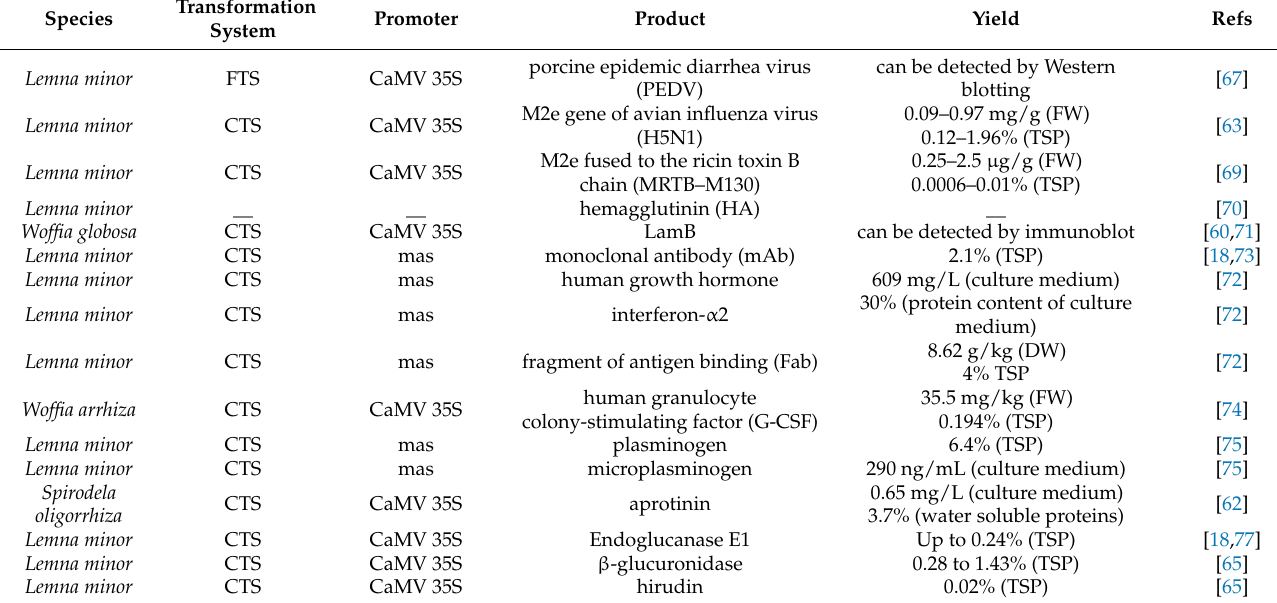
Table 5. Summary of duckweed synthesis